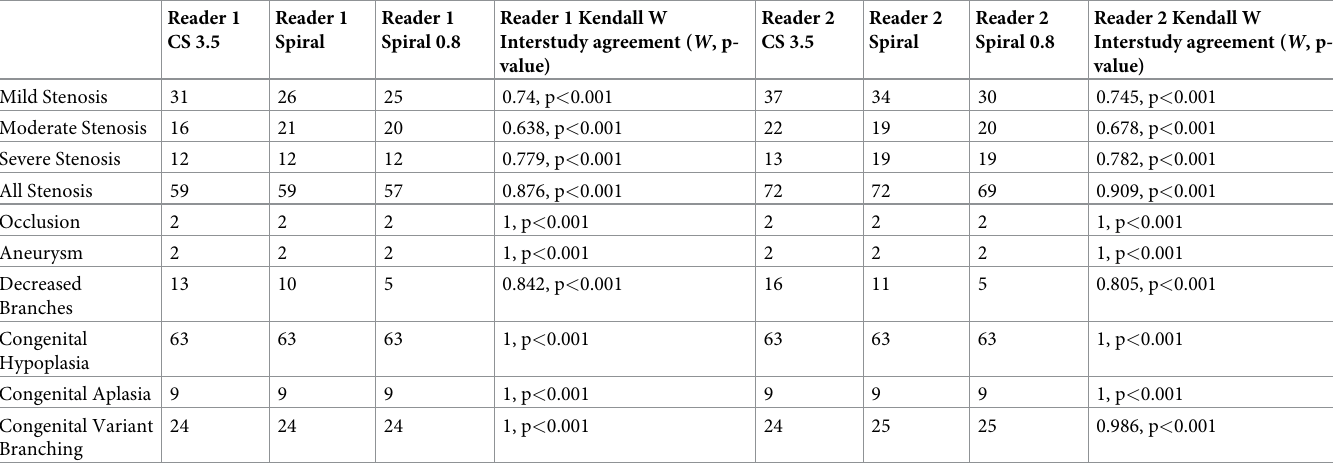
Table 3. Overview of the data from lesion and variation assessment. Reader 1 CS